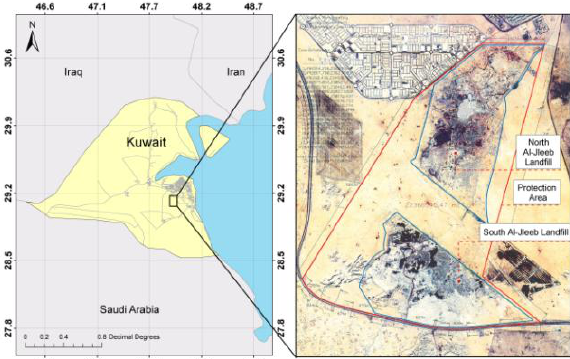
Figure 2. Study area of the Nepean and the Trail Road landfill